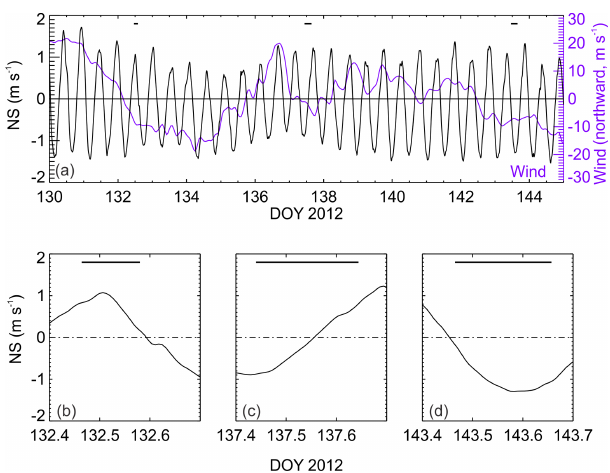
Figure 2. Sampling conditions showing average N–S (north-south aligned flow with northward being positive) water column velocity between 60 and 100m depth and wind speed – both filtered with an hourly low-pass filter. The bars show microstructure sample peri- ods. These bars are expanded in the daily sampling relative to tidal conditions is shown in (b) , (c) and (d) .